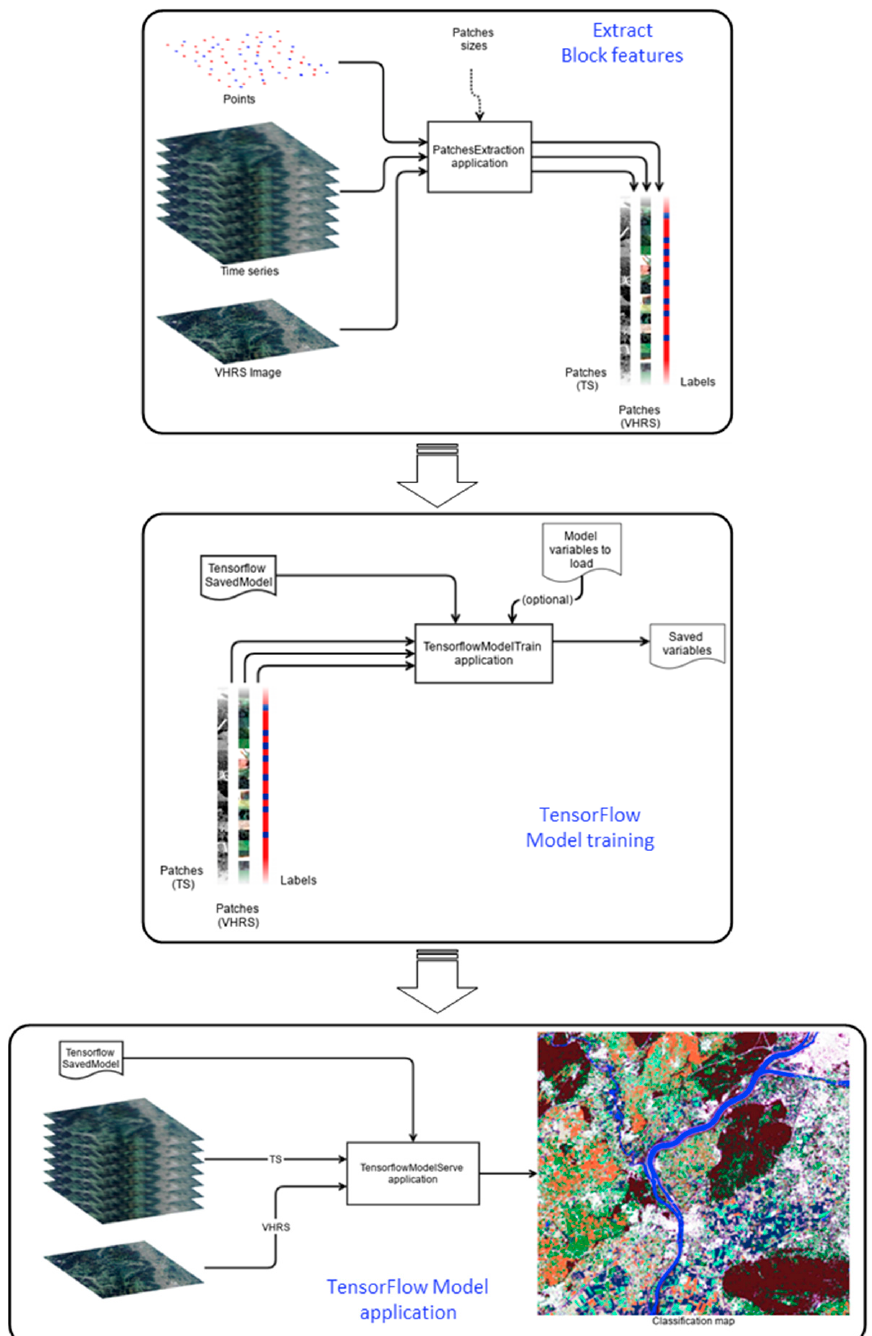
Figure 4. Applied TensorFlow stages of CNN.